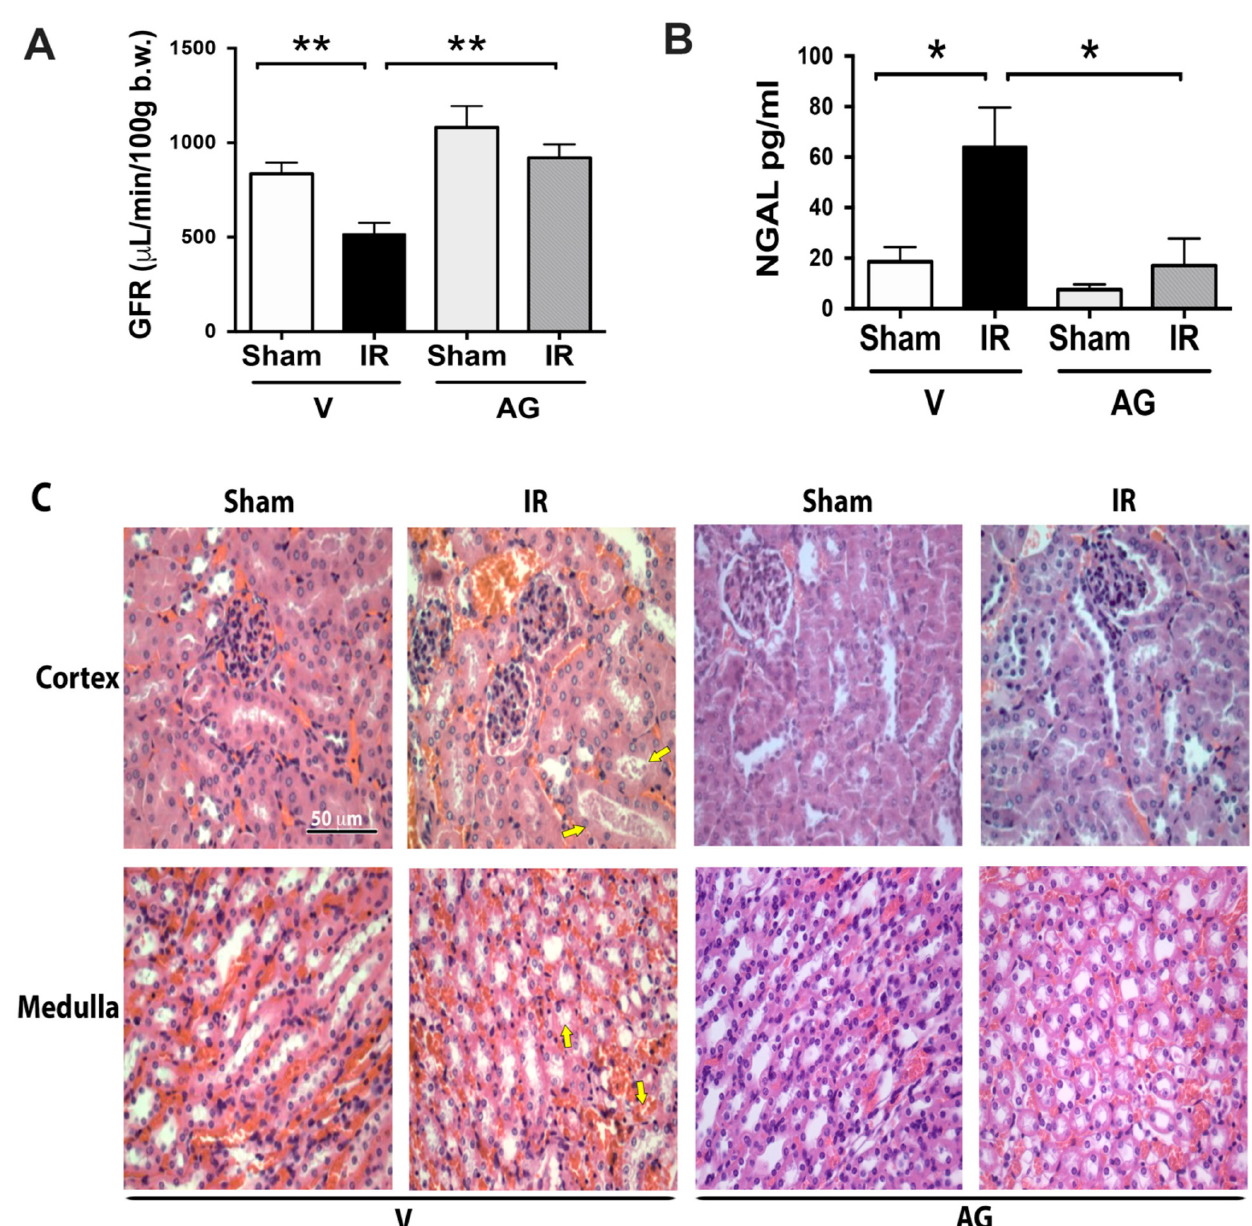
Figure 1. AG prevented the kidney damage induced by renal IRI. BALB/c mice were treated with either vehicle or AG (50 mg/kg i.p) before sham or ischemia-reperfusion (IR) surgery and subjected to 30 min of ischemia and 48 h of reperfusion. ( A ) GFR ( µ L/min/100 g body weight) was determined in sham (n = 5), IR (n = 6), AG-sham (n = 5), and AG-IR (n = 6). ( B ) Neutrophil gelatinase-associated lipocalin (NGAL) was measured by ELISA in blood samples in sham (n = 9), IR (n = 6), AG-sham (n = 5), and AG-IR (n = 6). The bar graphs represent mean ± SEM, and the data were analyzed using ANOVA and non-parametric Kruskal–Wallis test. * p < 0.05 and ** p < 0.005. ( C ) Histological analysis: representative hematoxylin/eosin (H/E) staining of the cortex and the medulla kidney sections. Yellow arrows indicate areas with evident kidney acute tubular necrosis (ATN) characterized by loss of nucleus in tubules or intratubular cellular detritus. Three kidneys for each protocol were analyzed. Representative images correspond to 400X scale bar = 50 µ